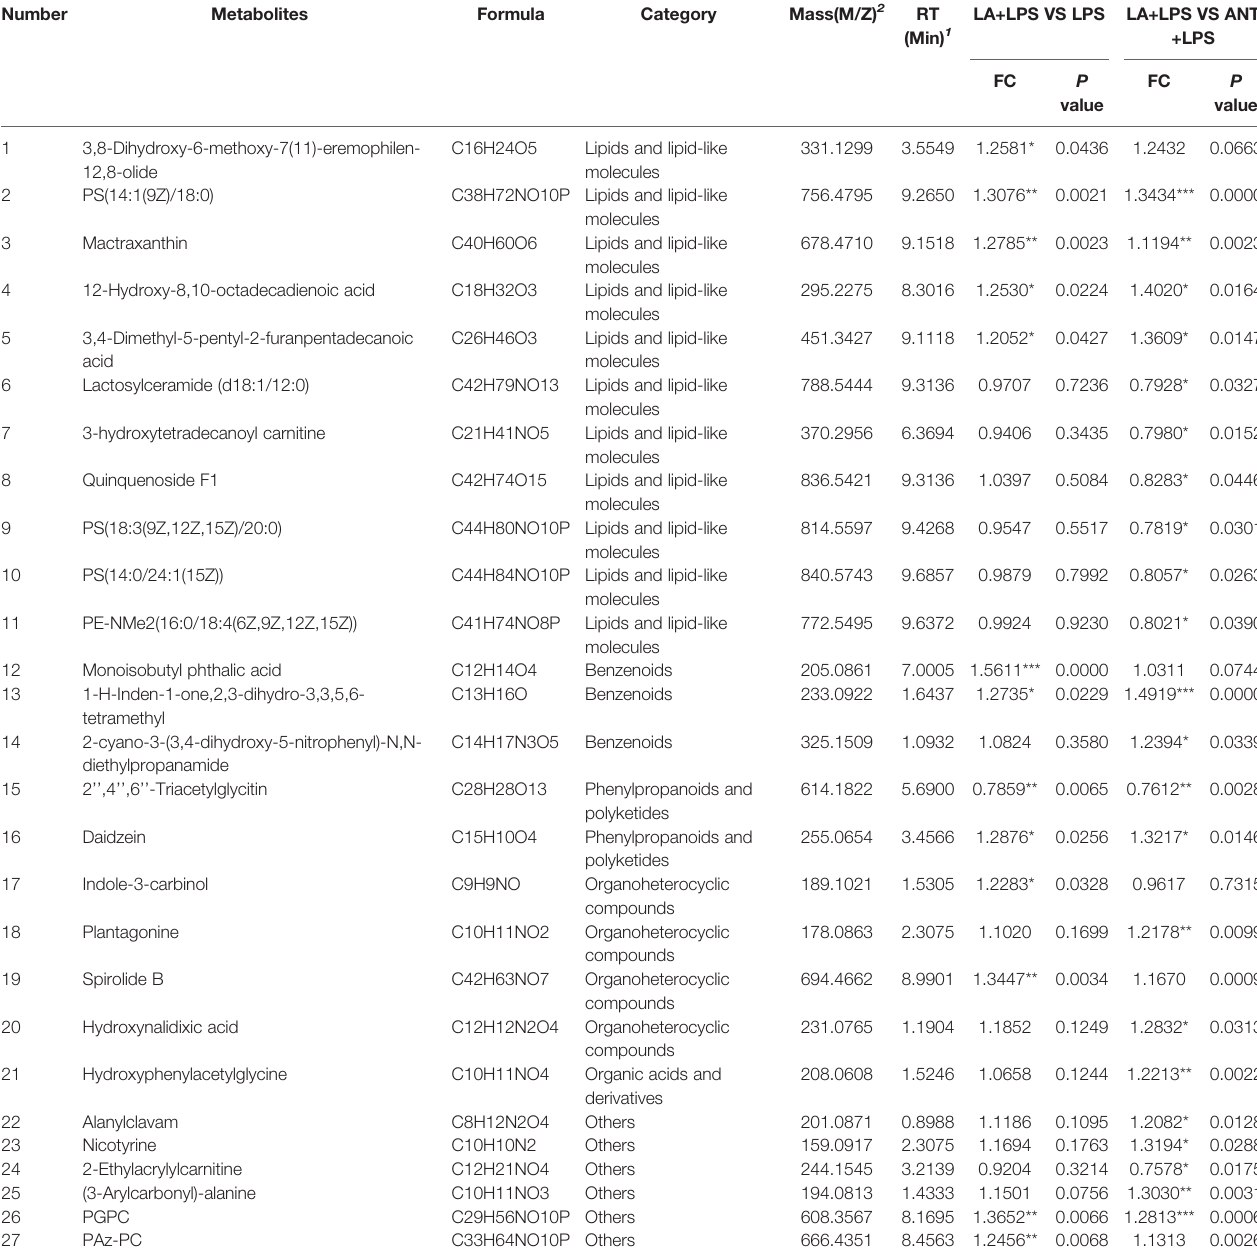
TABLE 2 | Comparisons of Serum metabolic